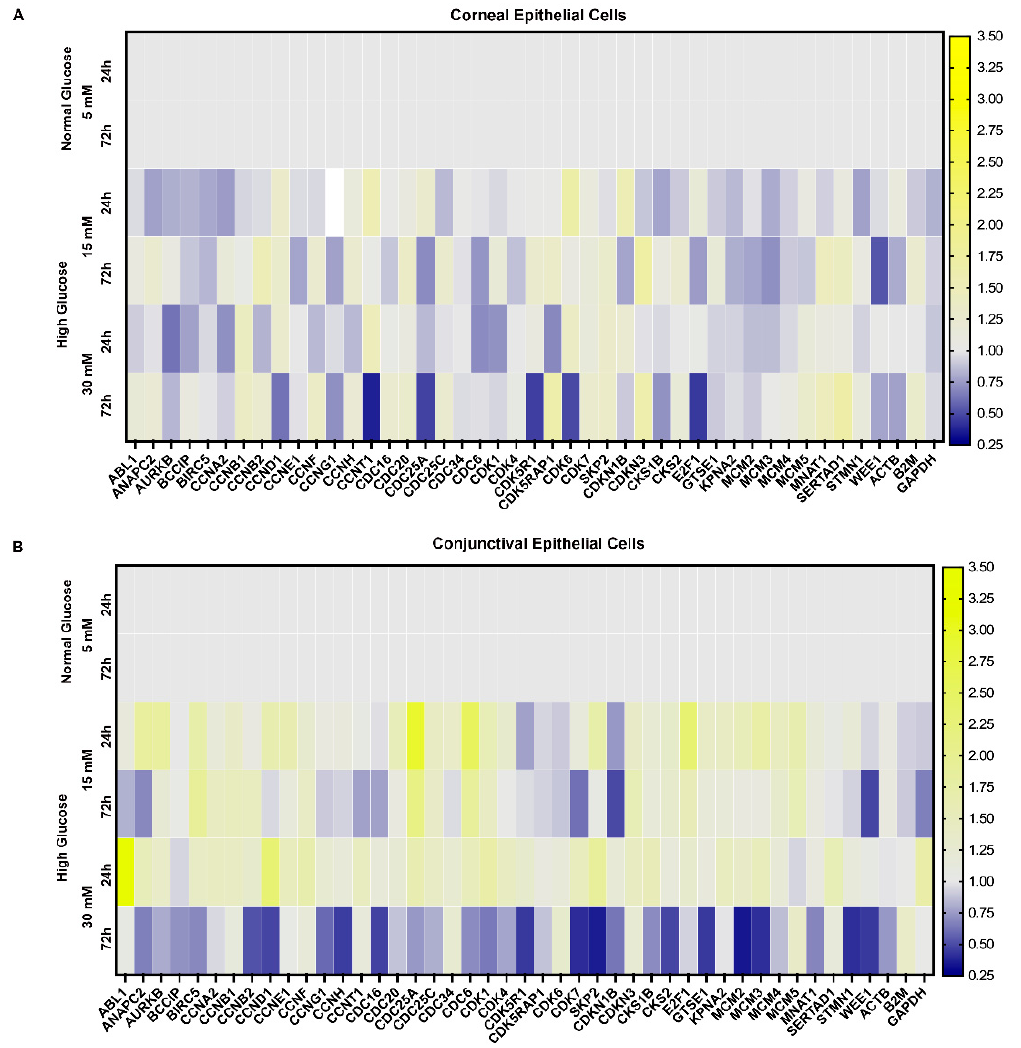
Figure 6. ( A ) Heat map showing changes in gene expression of proteins involved in proliferation and cell cycle in stratified human corneal epithelial cells exposed to high glucose concentration (15 mM; 30 mM). ( B ) Heat map showing changes in gene expression of proteins involved in proliferation and cell cycle in stratified human conjunctival epithelial cells exposed to high glucose concentration (15 mM; 30 mM). The proteins that show a fifty percent or higher decrease in expression are depicted in blue.